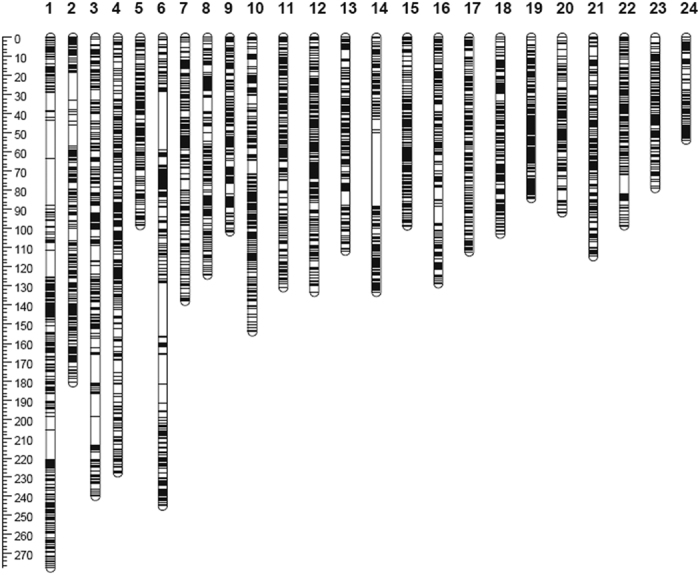
Linkage group lengths and marker distribution of the high-resolution restriction site-associated DNA sequencing-based SNP genetic map of M. amblycephala.